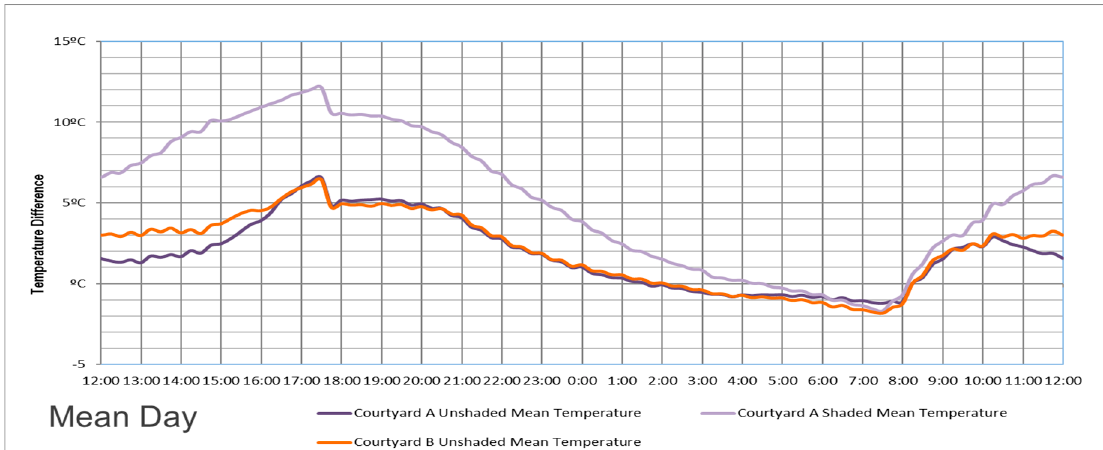
Figure 4. Mean Outdoor- Indoor temperature difference at each hour of the